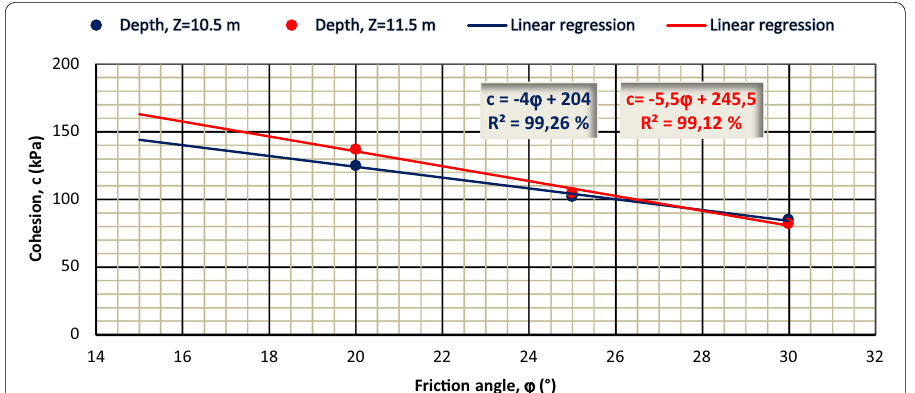
Fig. 14 Determination of c and ϕ for simplex method